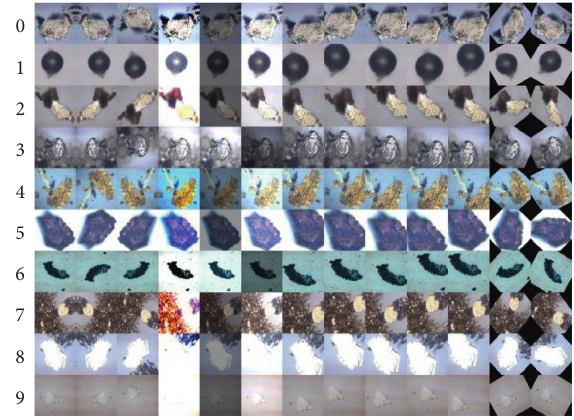
Figure 6: Expansion diagram of wear particle